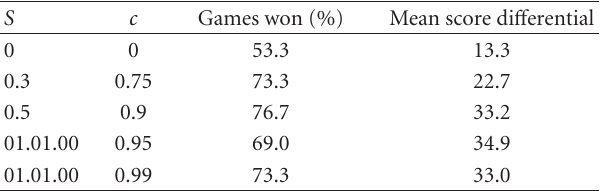
Figure 9: Number of winning configurations versus the size of training data. Table 1: Performance versus simulated annealing parameters.